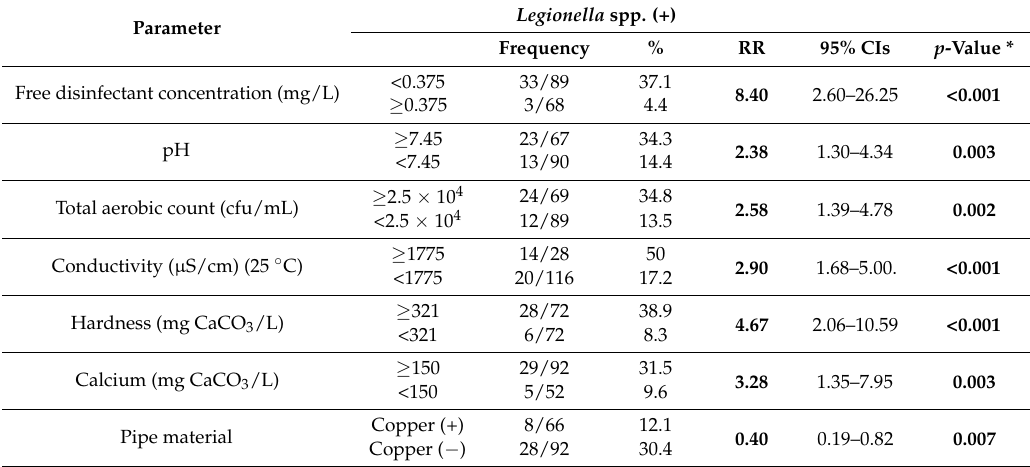
Table 4. Univariate analysis for colonization of water supply systems with Legionella spp.